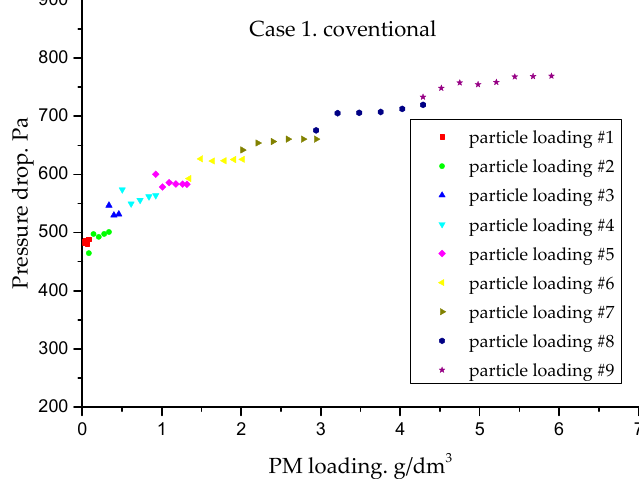
Figure 7. Pressure drop of case 1 during particle loading. PM: particulate matter.